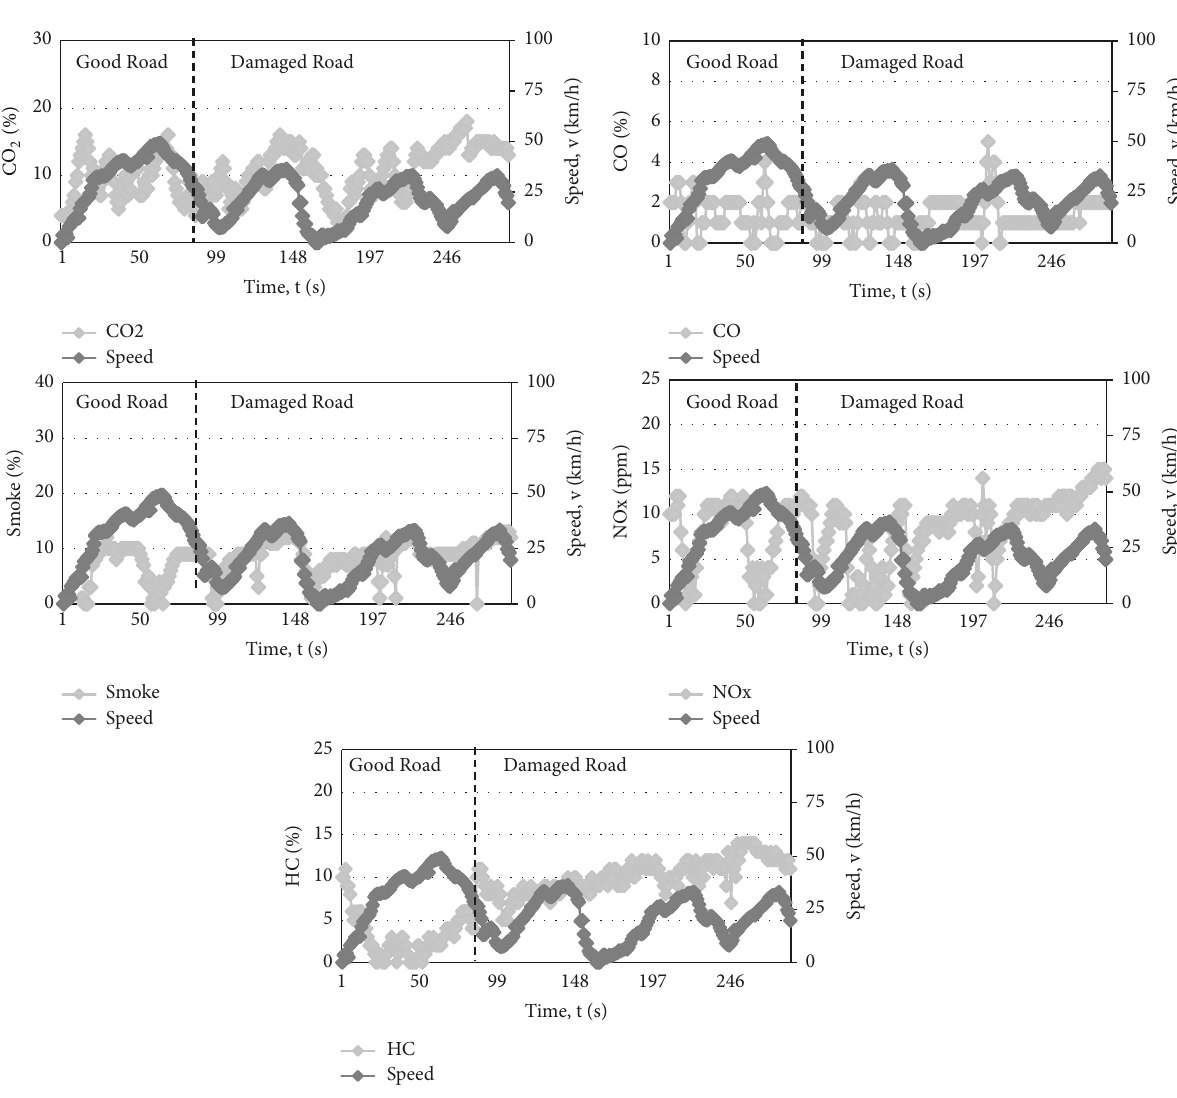
Figure 4: Spectrum of emission recording CO 2 , CO, Smoke, NOx, and